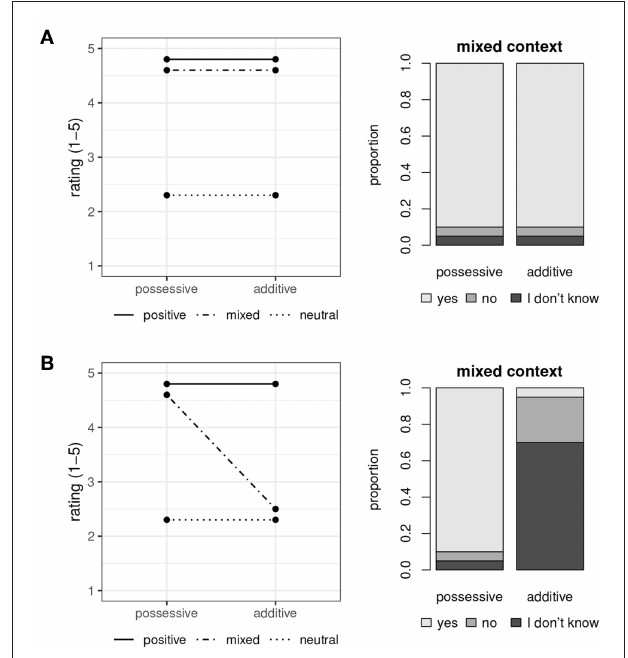
FIGURE 1 | The SALIENT INDIVIDUAL account (A) predicts no interaction, but a significant difference between mixed/positive and neutral context. The SALIENT PROPOSITION account (B) predicts an interaction between TRIGGER TYPE (possessive/additive) and CONTEXT